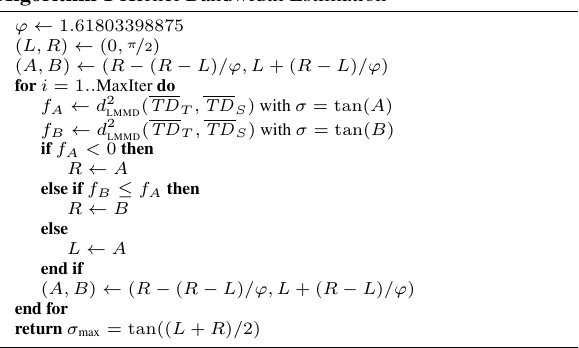
Algorithm 1 Kernel Bandwidth